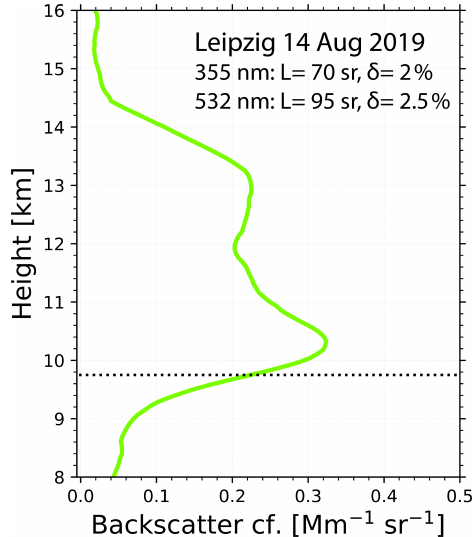
Figure 15. The 80min mean height profile of the 532nm par- ticle backscatter coefficient showing an extended smoke layer in the UTLS region from 9–14.5km height over Leipzig, Germany (51.3 ◦ N), on 14 August 2019 at 00:00–01:20UTC. The measured layer-mean particle lidar ratios (L) and particle depolarization ratios ( δ ) at 355 and 532nm are given as numbers and are typical for aged, spherical smoke particles. The dotted line shows the tropopause as measured by a nearby